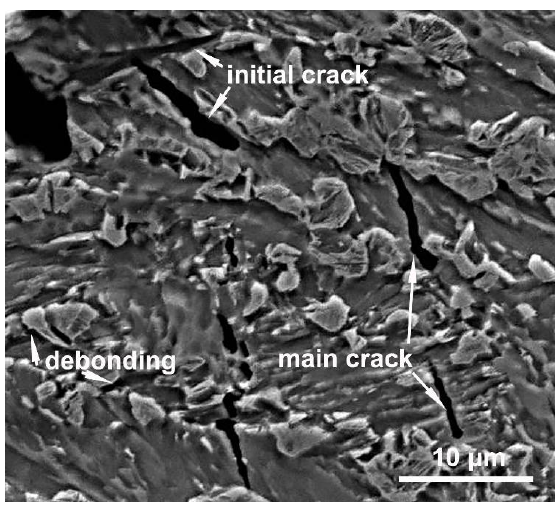
Figure 8. Secondary cracks near the fracture surface; peak temperature = 770 °C.